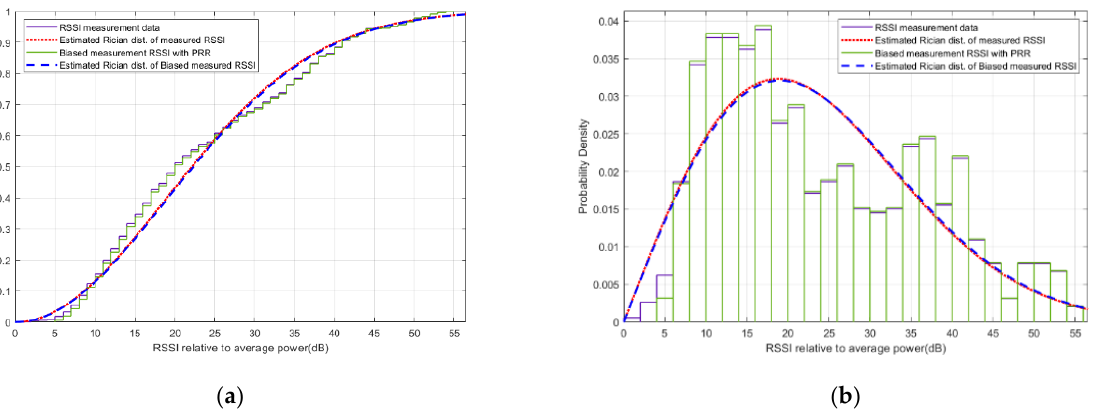
Figure 7. ( a ) CDF and ( b ) PDF of conventional and biased Wi-SUN channel approximation (2FSK-433-50 alias).